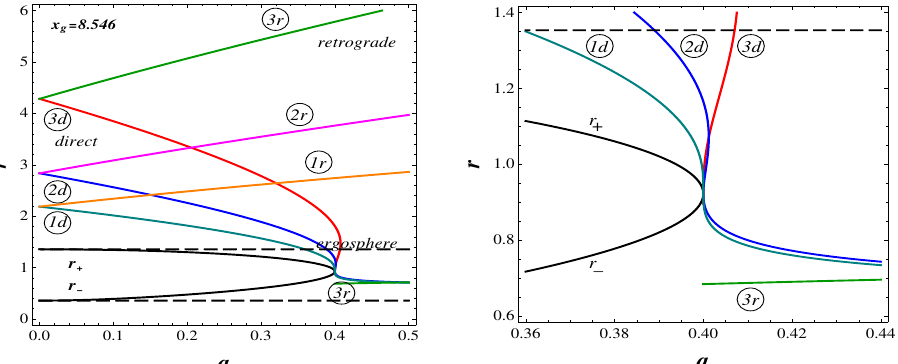
Figure 5. Limiting orbits in the de Sitter–Kerr geometry dependently on a ( Left ), and the enlarged image near the double horizon ( Right